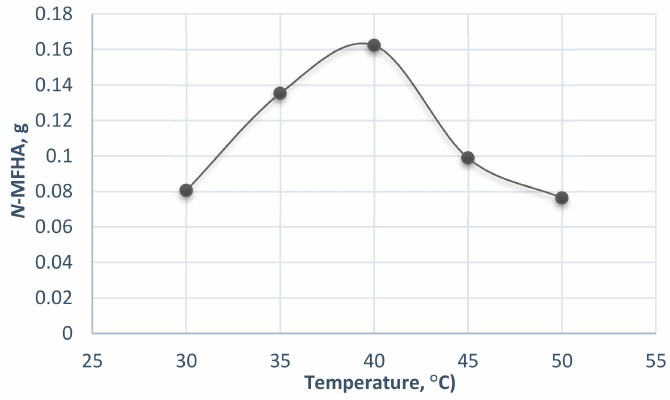
Figure 4. E ff ect of temperature: 2 g of oil, 10 mmol of N -methylhydroxylamine, 15 mL of hexane, 0.02 g of Lipozyme TL IM, and 25 h of incubation